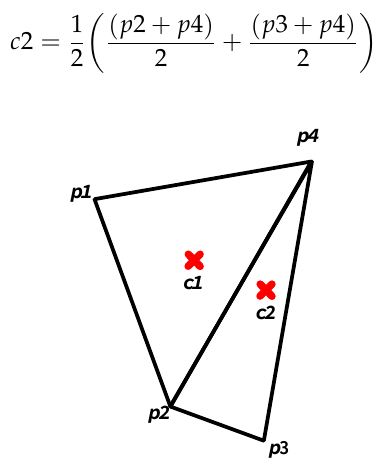
Figure 6. Skeleton points of a triangle mesh.